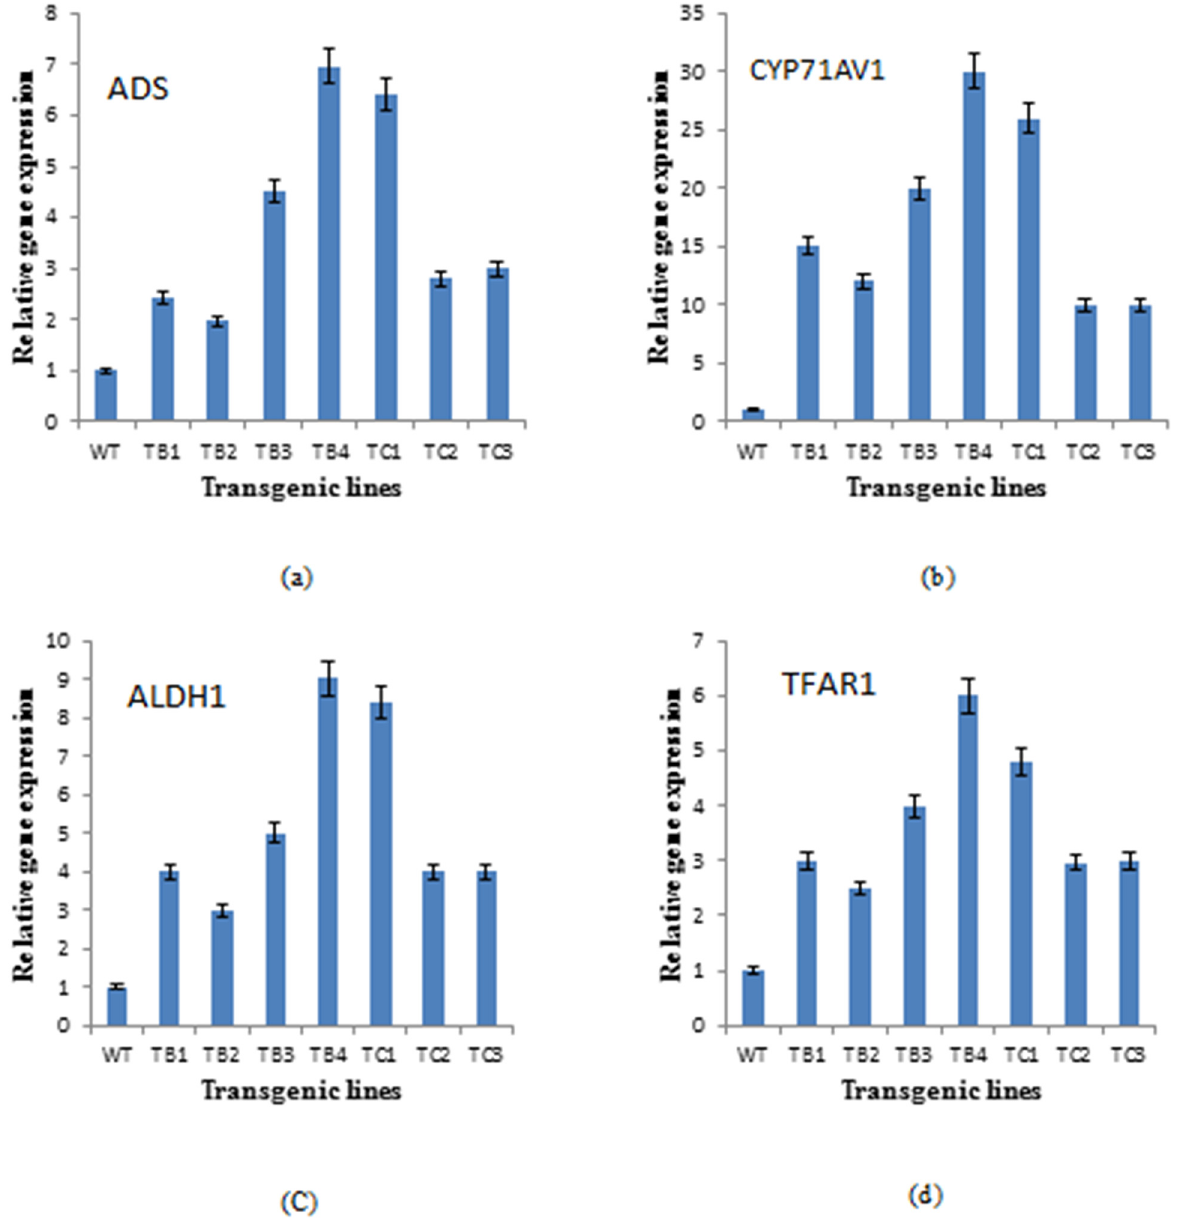
Fig 9. Expression analysis of artemisinin biosynthetic pathway genes and TAFR1 gene. Expression level of Artemisinin biosynthetic genes, ADS (a), CYP71AV1 (b) and ALDH1 (c) in wild type plant of A . carvifolia and transgenics of rol B and rol C gene. TFAR1 is the gene involved in trichome development and sesquiterpenoid biosynthesis